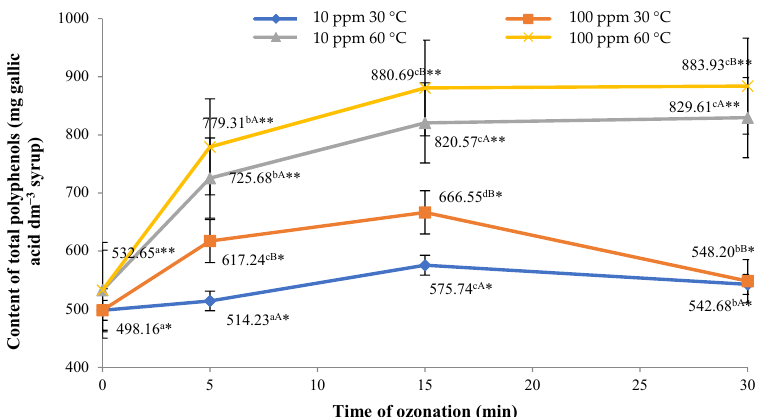
Figure 3. Total contents of polyphenols in syrups from flowers of black elder, relative to the dose of ozone applied and temperature of sugar syrup used. Note: Differences in results between the time of ozonation (for certain ozone concentration) are indicated by different small letters, differences between ozone concentration (for certain ozonation time) are indicated by different capital letters and differences between sugar syrup temperatures are indicated by * or ** (for the same ozone-treatment conditions) at α < 0.05.